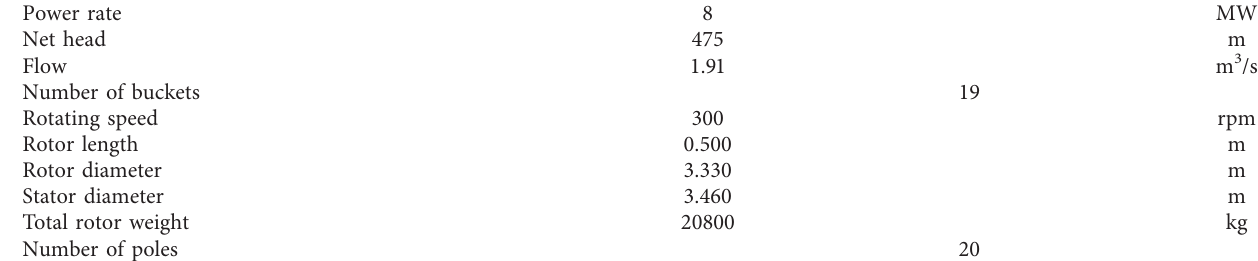
Table 4: Horizontal Pelton turbine, Case II.